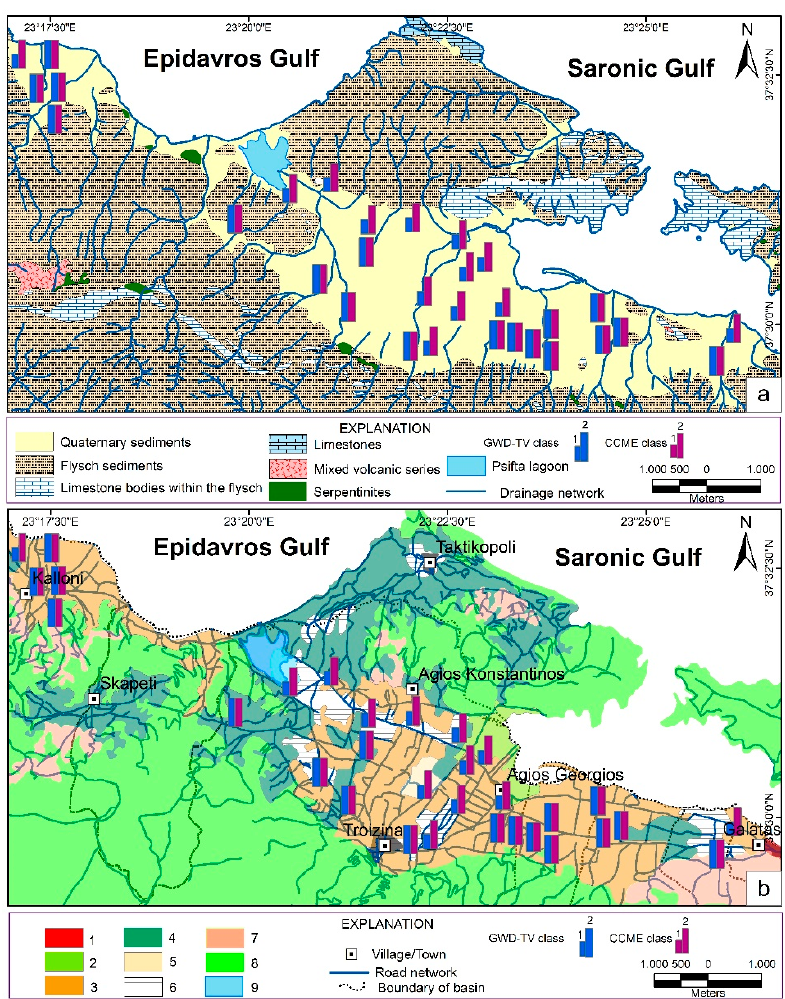
Figure 6. Spatial distribution of GWD-TV and CCME-WQI classes in groundwater monitoring stations compared with ( a ) geology and ( b ) land uses (the explanation of land uses is shown in the caption of Figure 2).